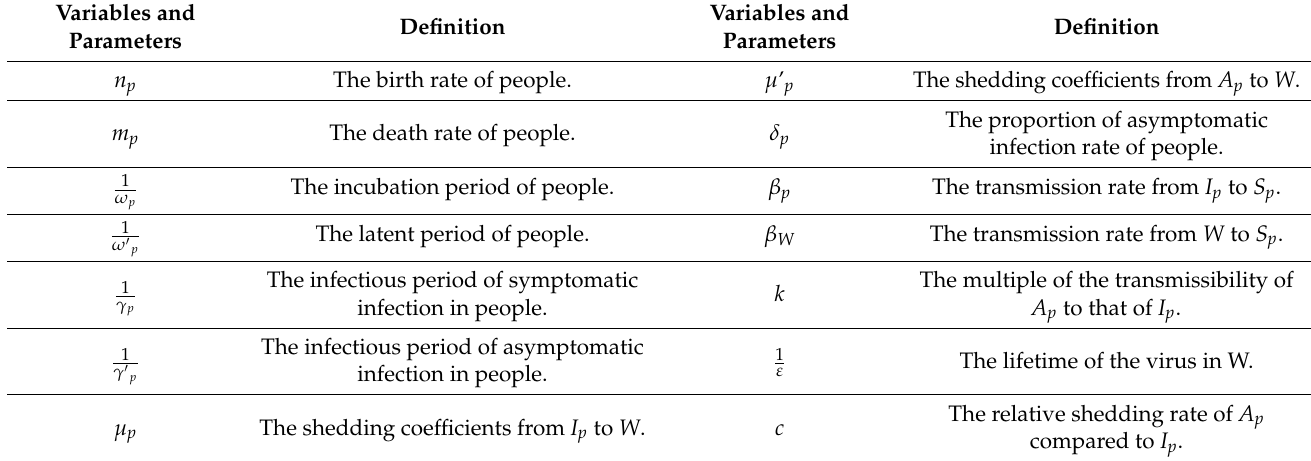
Table 1. Variables and